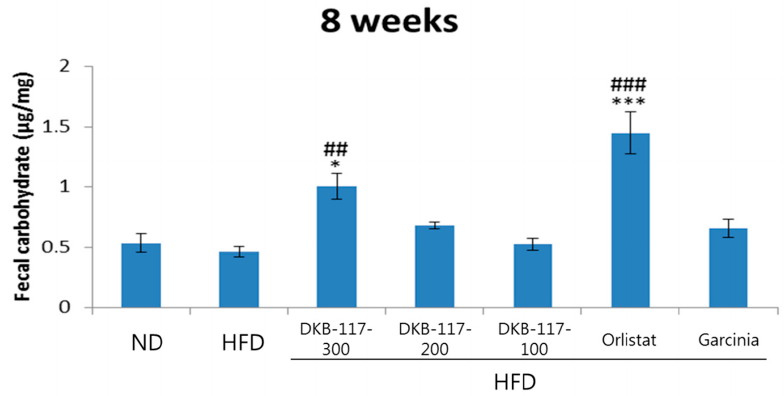
Figure 5. Effect of DKB-117 extracts on liver TG levels in HFD-induced obese mice. The values are presented as means ± SEMs. *** A significant difference at the p < 0.001 level versus the ND. ##/# A significant difference at the p < 0.01/ p < 0.05 level versus the HFD. ND, normal diet control group; HFD, high-fat diet control group; DKB-117-300, DKB-117 300 mg/kg; DKB-117-200, DKB-117 200 mg/kg; DKB-117-100, DKB-117 100 mg/kg; Orlistat, orlistat 40 mg/kg; Garcinia, Garcinia cambogia 200 mg/kg.